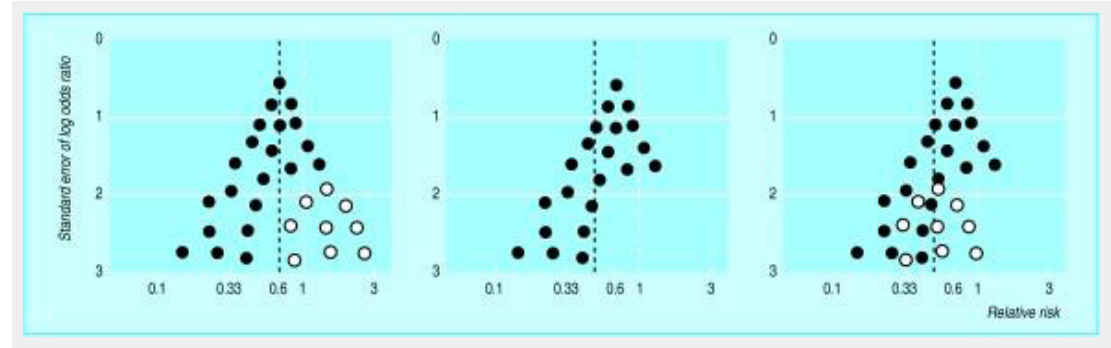
Hypothetical funnel plots: left, symmetrical plot in absence of bias (open circles are smaller studies showing no beneficial effects); centre, asymmetrical plot in presence of publication bias (smaller studies showing no beneficial effects are missing); right, asymmetrical plot in presence of bias due to low methodological quality of smaller studies (open circles are small studies of inadequate quality whose results are biased towards larger effects). Dotted black lines are pooled summary estimates and dotted white lines are null effects (RR 1.0). Pooled estimates exaggerate treatment effects in presence of bias (from Sterne et al. Investigating and dealing with publication and other biases in meta-analysis. BMJ. 2001;323:101–5. Reprinted with the permission from BMJ Publishing Group